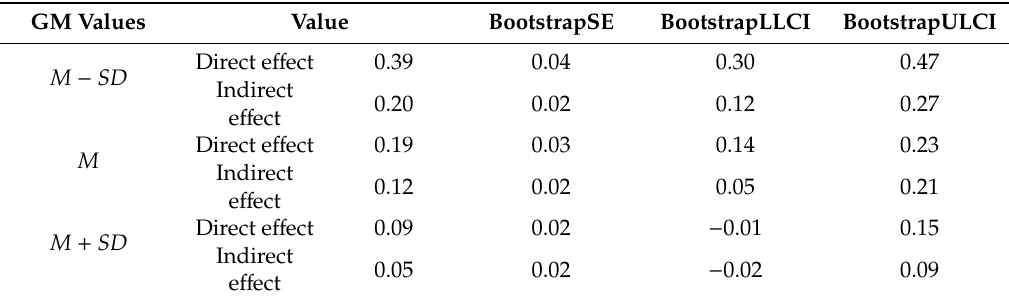
Table 3. Conditional direct and indirect e ff ects analysis.